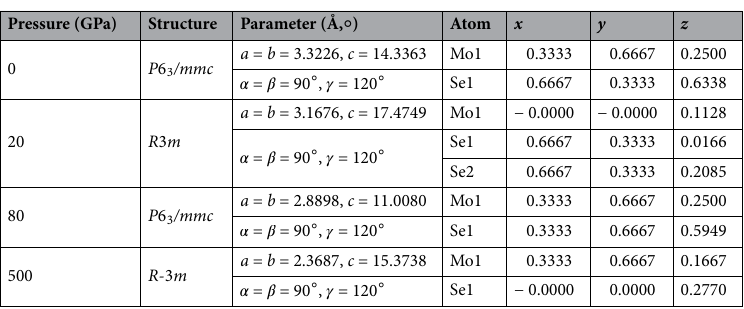
Table 1. Calculated lattice constants and atomic coordinates of MoSe 2 under selected pressures.